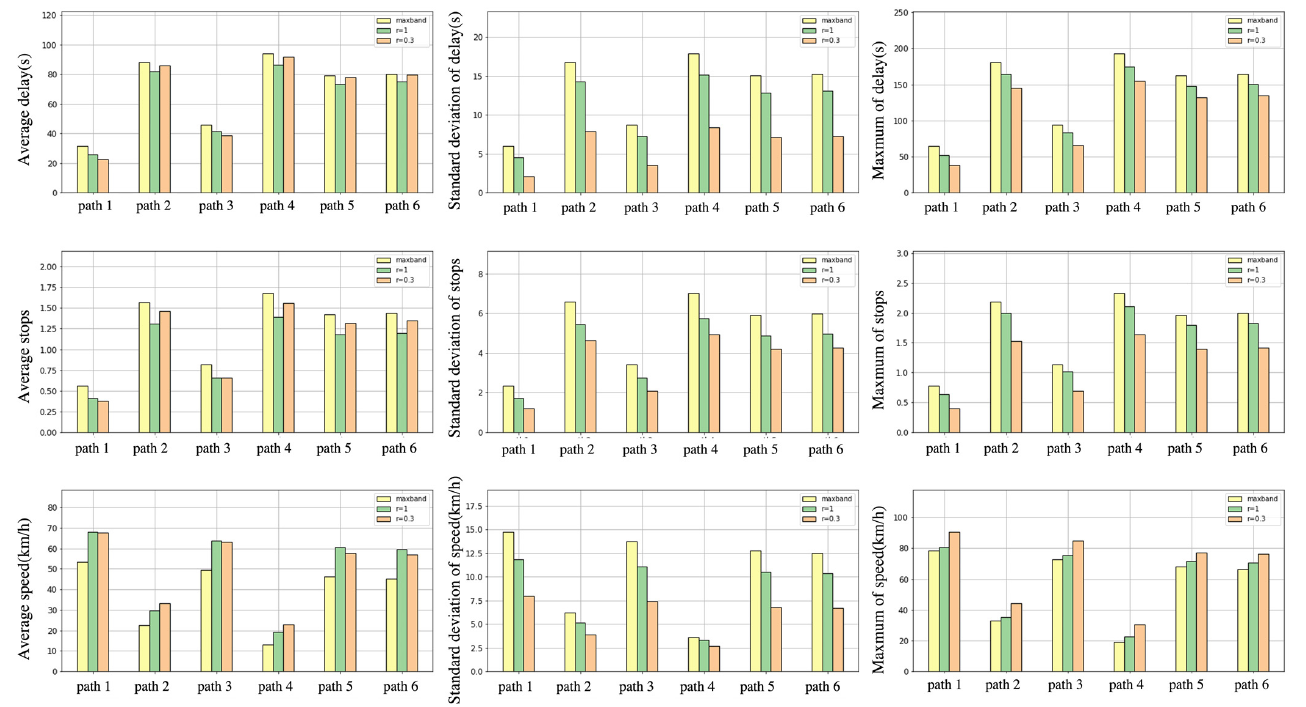
Figure 13. Operating parameters of each path. Table 3. Arterial performance under the control of different models.